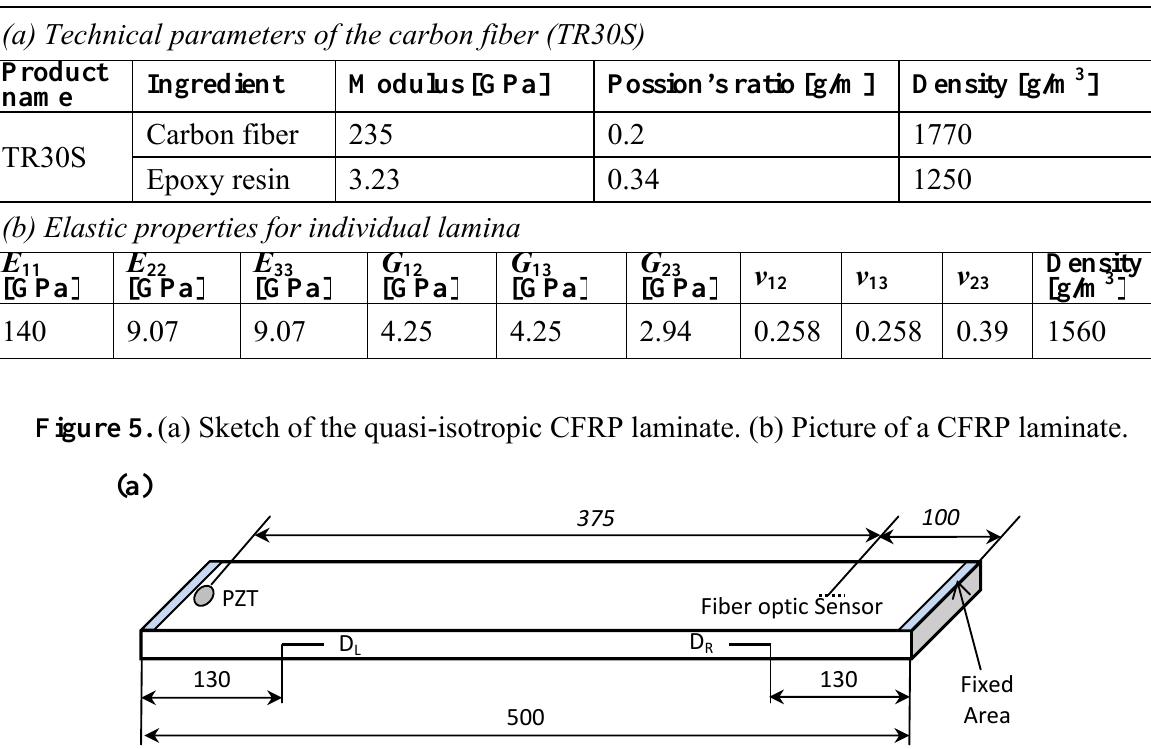
Table 1. Technical parameters of the carbon fiber (TR30S).